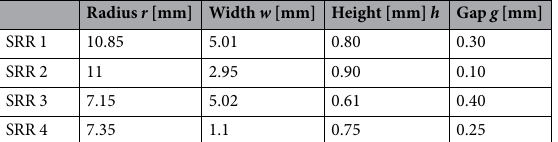
Table 2. Geometrical parameters of the SRR probes used in the experiments and simulations shown in Fig.